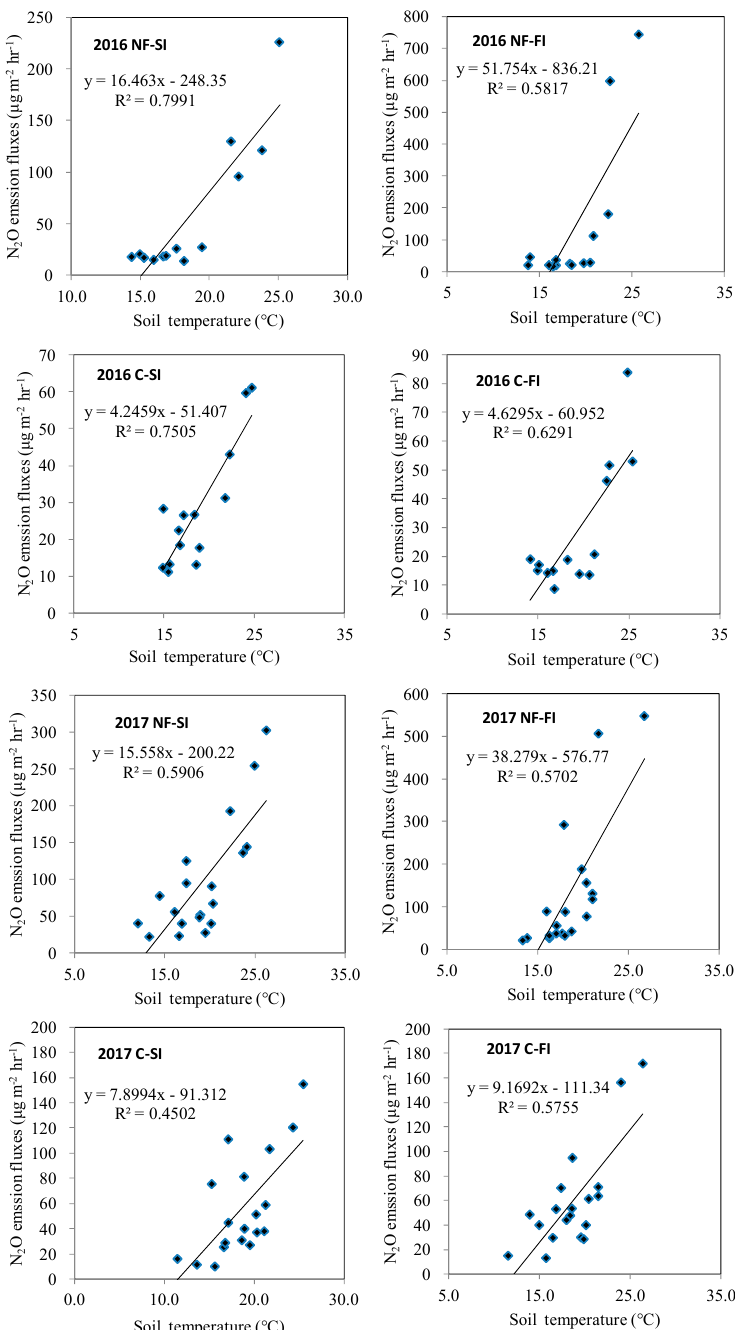
Figure 4. Correlation analysis between soil temperature and N 2 O emission fluxes under NF-SI, NF-FI, C-SI, and C-FI conditions in 2016 and 2017.